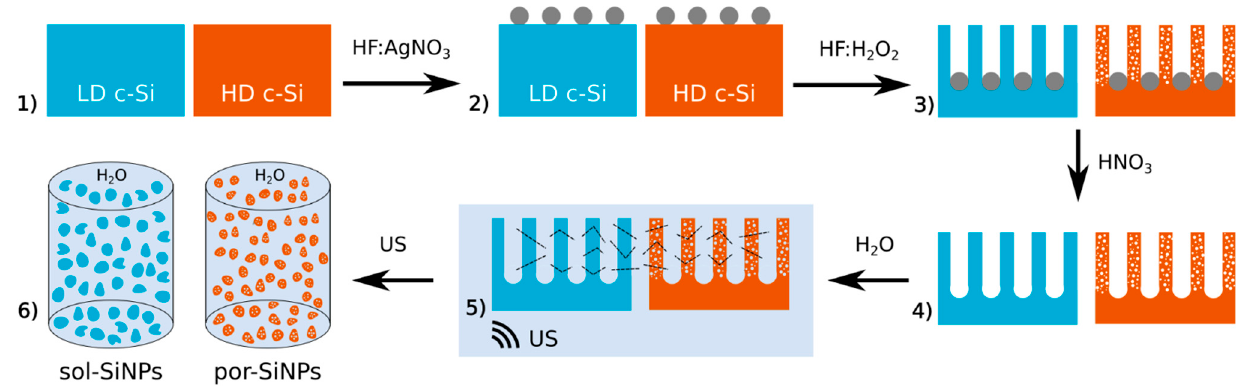
Figure 1. Schematic representation of both sol-SiNPs (blue) and por-SiNPs (brown) formation. Stages followed by arrows: (1) bulk low-doped (LD) and high-doped (HD) c-Si wafers; (2) Ag nanoparticles (gray circles) deposited on the c-Si surfaces; (3) SiNW layers formed by Ag-assisted chemical etching of the c-Si wafer with remnant AgNPs at the bottom of the layer; HD SiNWs exhibit porous structure; (4) SiNW layers after dissolution of AgNPs; (5) SiNWs under ultrasonic (US) treatment, dashed lines show fractures caused by US; (6) The resulting aqueous suspensions of sol- and por-SiNPs. Arrows are accompanied by chemical formula of reagents/medium.